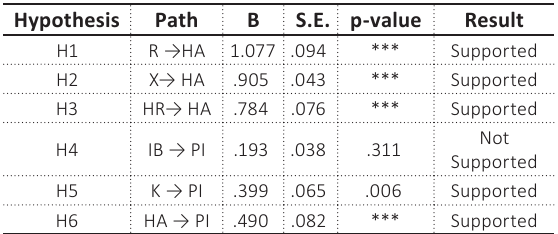
Table 5. SEM results for testing the hypotheses